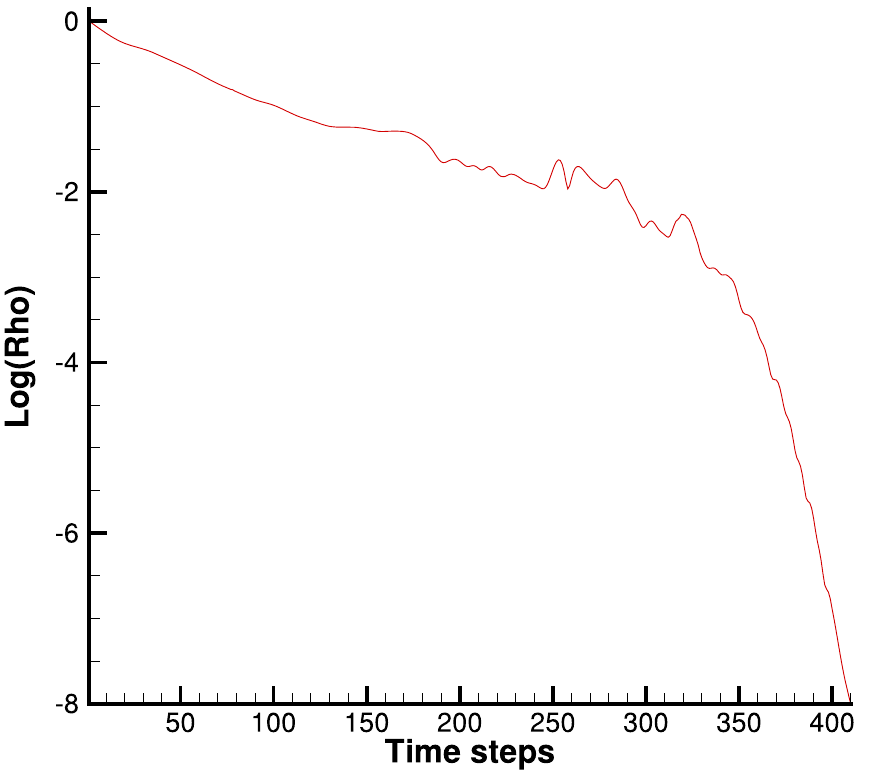
Fig. 16 Residual convergence history of the transonic flow over DLR-F4